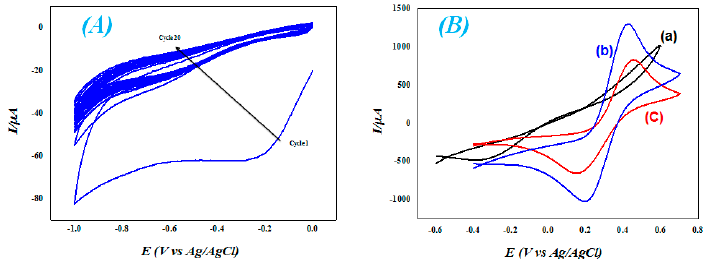
Figure 1. Electro-grafting of 4-carboxybenzenediazonium tetrafluoroborate. ( A ) Electroreduction, ( B ) Passivation test: (a): uncleaned gold electrode; (b): cleaned electrode and (c): after electro-grafting of the diazonium salt.